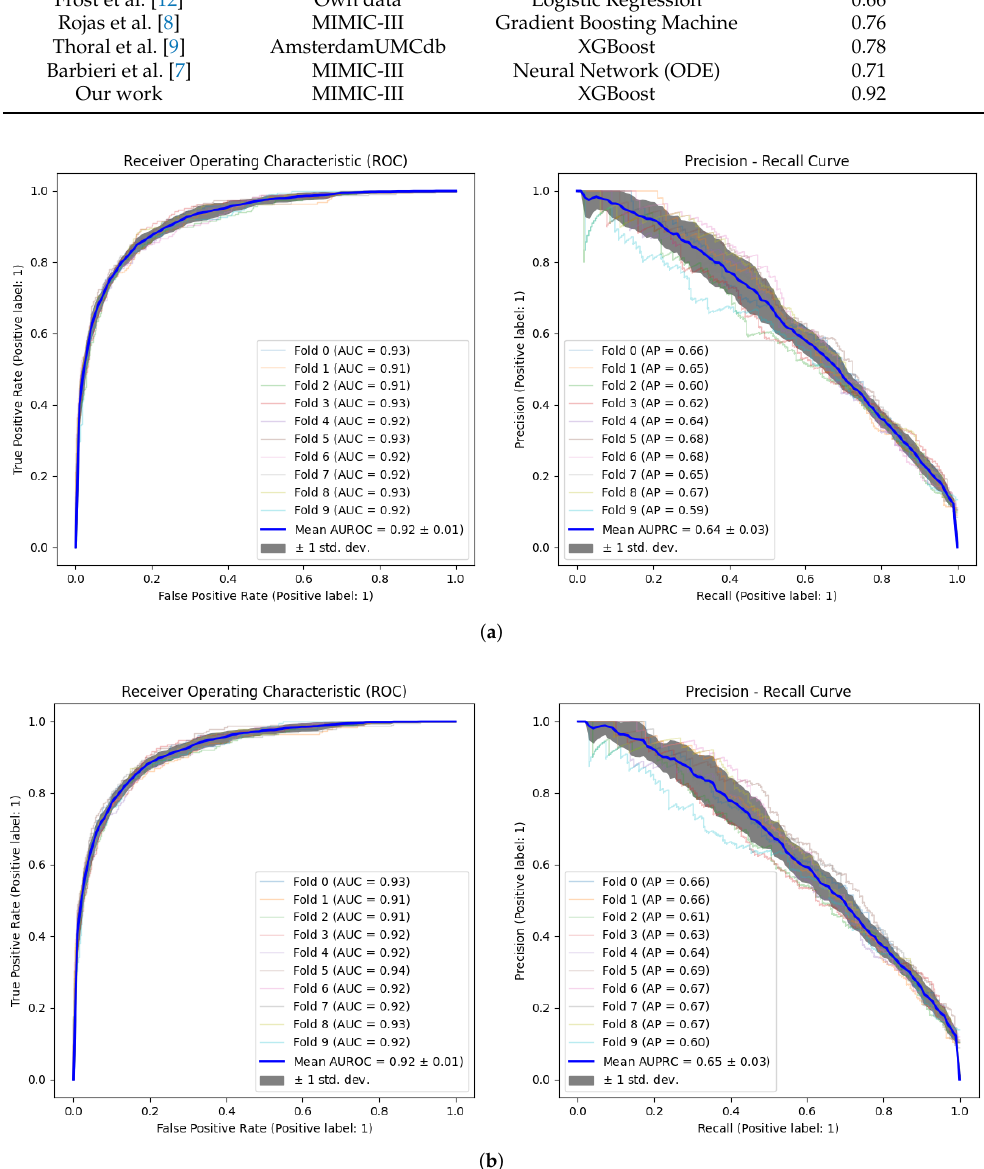
Figure 4. ROC and Precision–Recall curves using the different optimization criteria: ( a ) Using AUROC as optimization criterion. ( b ) Using AUPRC as optimization